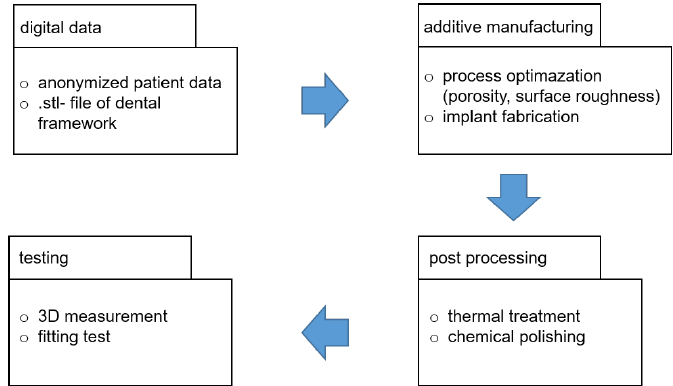
Figure 4. Experimental work flow carried out to fabricate the dental